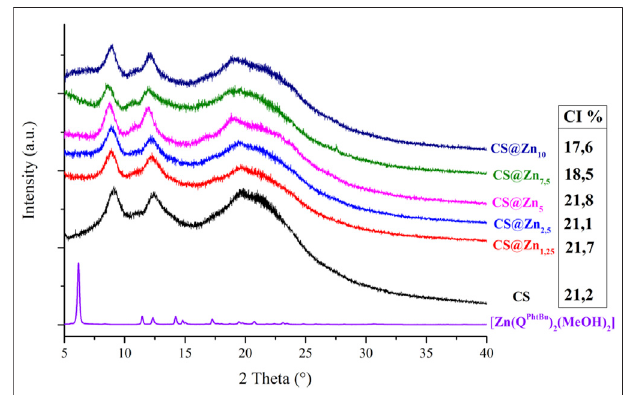
FIGURE4| PXRDpatternsofthecomplex[Zn(Q PhtBu ) 2 (MeOH) 2 ]andthe ionic CS fi lms and CI% values calculated for the CS fi